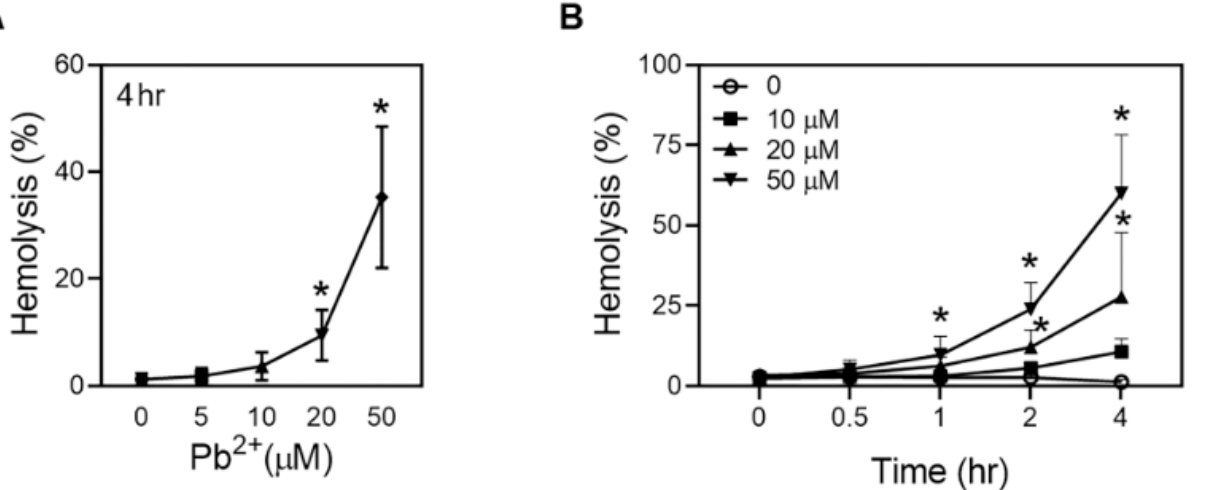
Figure 1. Effects of Pb on hemolysis in freshly isolated human erythroid cells. After erythroid cells were treated with distilled water (DW; control) or various concentrations (0, 5, 10, 20, and 50 µ M) of Pb, hemolysis was evaluated at 540 nm. ( A ) Concentration-dependent Pb was treated for 4 h ( n = 4). ( B ) Time- and concentration-dependent courses were measured with various concentrations of Pb up to 4 h ( n = 4–7). Values are the mean ± SD of 4–7 experiments. * Statistical difference compared with control ( p < 0.05).